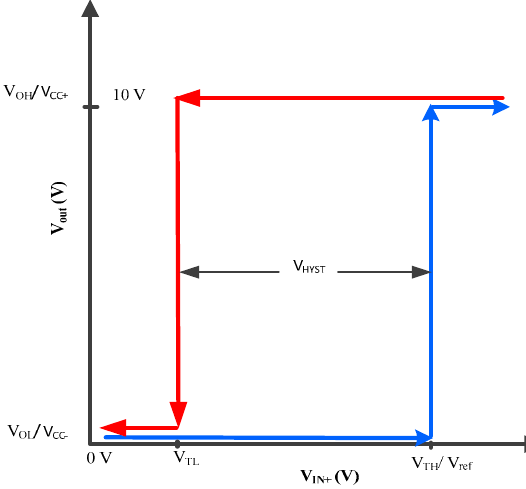
Figure 12. Hysteresis curve of comparator operation.